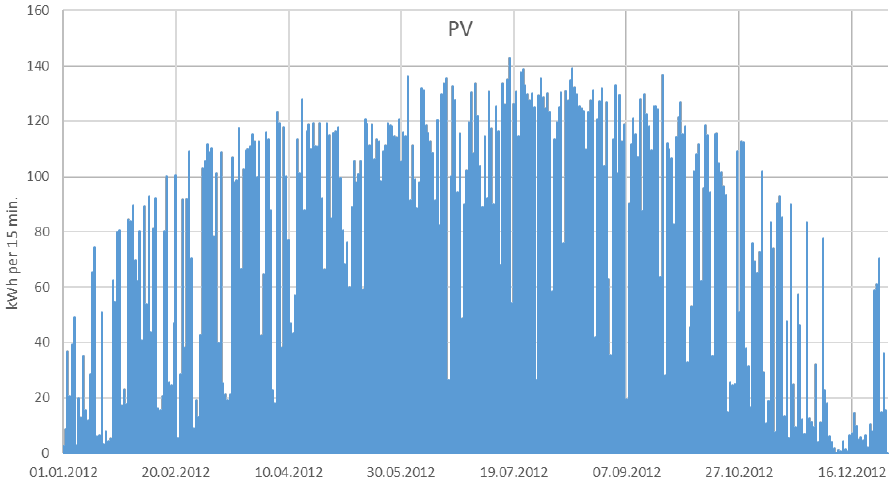
Figure 3. Daily electricity production with the help of a 645 kWp PV system, measured based on 15 min values from Neustrelitz solar park, Germany, 2012; annual output approximately 645,000 kWh.